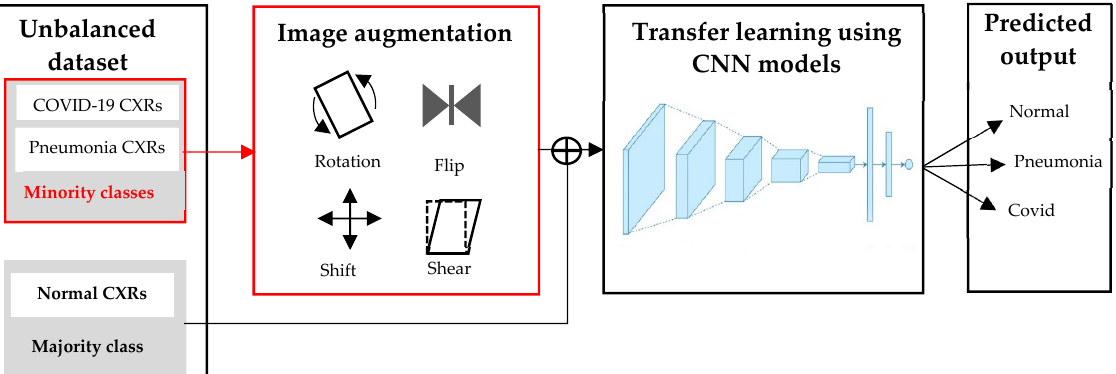
Figure 9. Deep learning with image augmentation on the unbalanced dataset.